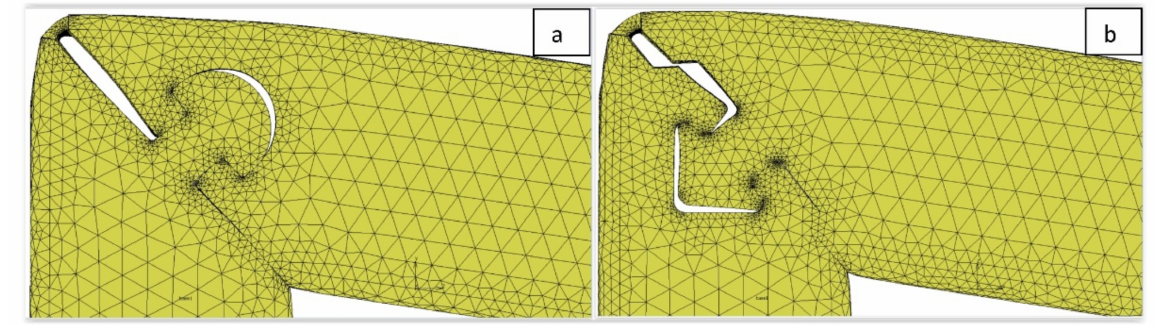
Figure 11. Examples of mesh modifications around the semicircular ( a ) and arrow lock areas ( b